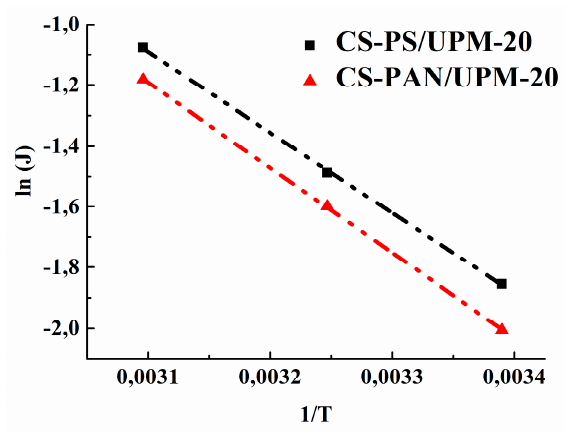
Figure 9. The dependence of ln(J) on 1/T in pervaporation of a THF-water mixture (5.7 wt. % water) by CS-PAN and CS-PS composite membranes. Table 6. Activation energy for composite membranes.